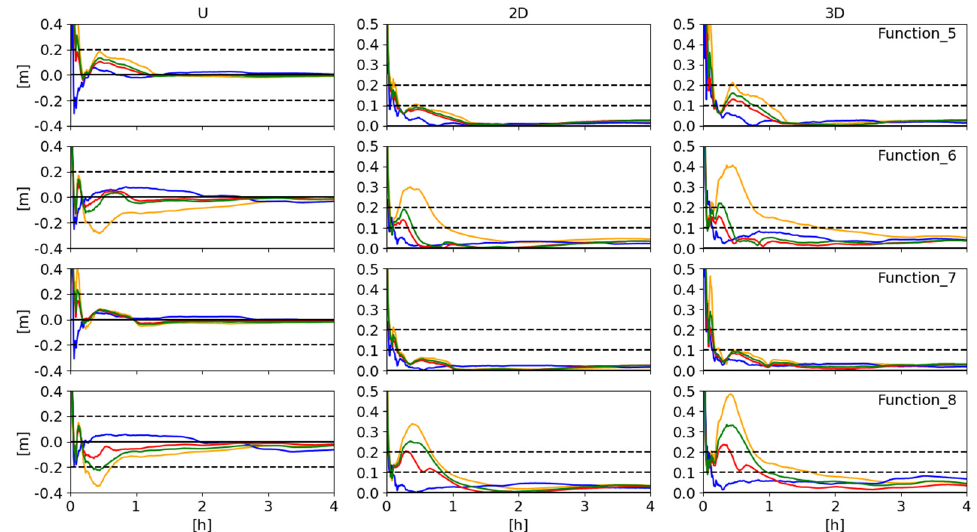
Figure 4. Time series of U component, 2D and 3D errors for the first four hours for the weighting functions. Functions 1 − 4 for the MAS100ESP station for the 39 DoY for all solutions. Blue − E solution, orange − G solution, red − GE solution, green − GE1 solution.